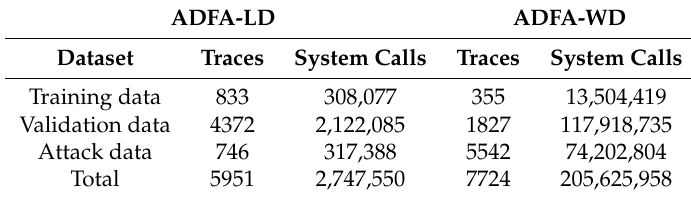
Table 3. Number of system calls traces in various categories of AFDA-LD and AFDA-WD datasets.